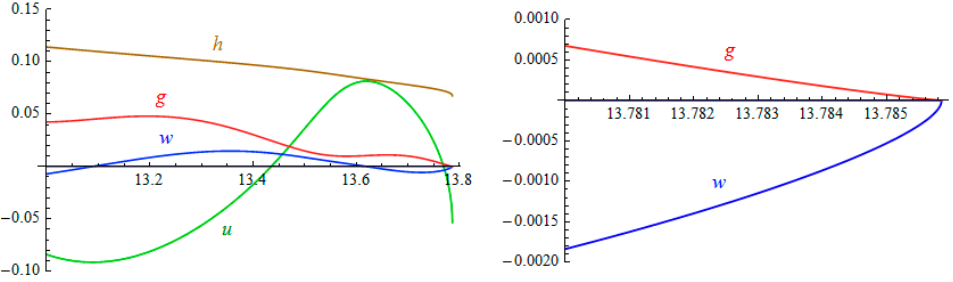
Figure 3. The same functions u ( x ) , w ( x ) , g ( x ) , and h ( x ), as in Figure 2, near x h (left graph), and very close to the horizon x h (right graph).